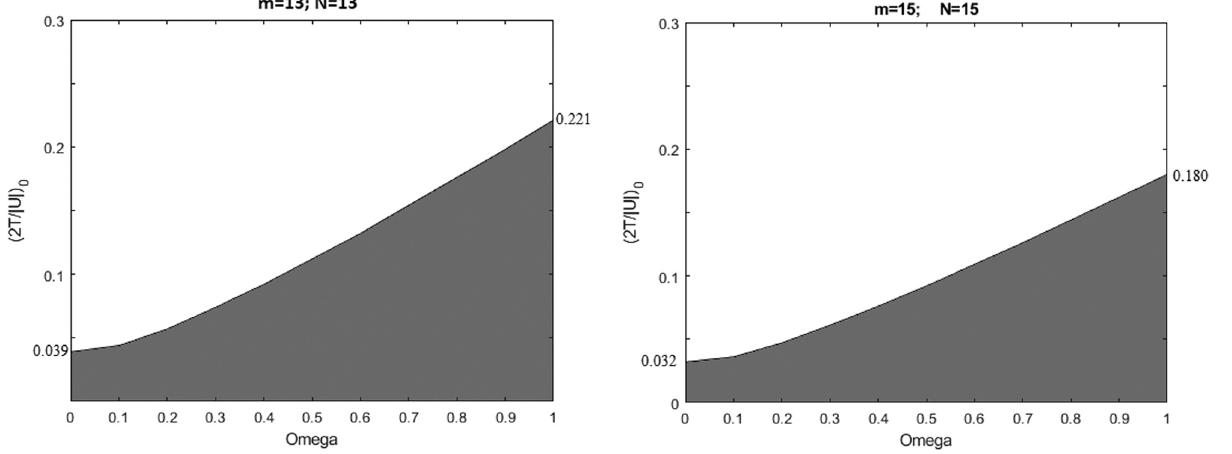
Figure 4: Critical dependence of the virial ratio on the rotation parameter for m 13 = ; N 13 = .